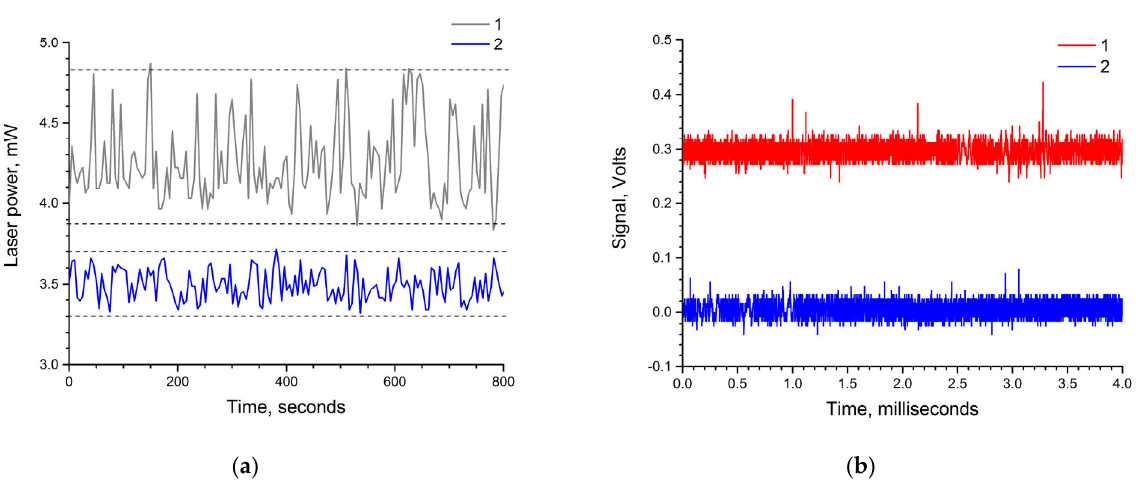
Figure 5. Dependences of the output power on time, measured at a constant pump power level: ( a ) in resonators with lengths of 6 (“1”) and 1.8 (“2”) m; ( b ) in a resonator with a length of 1.8 m below (“1”) and above (“2”) the lasing threshold.